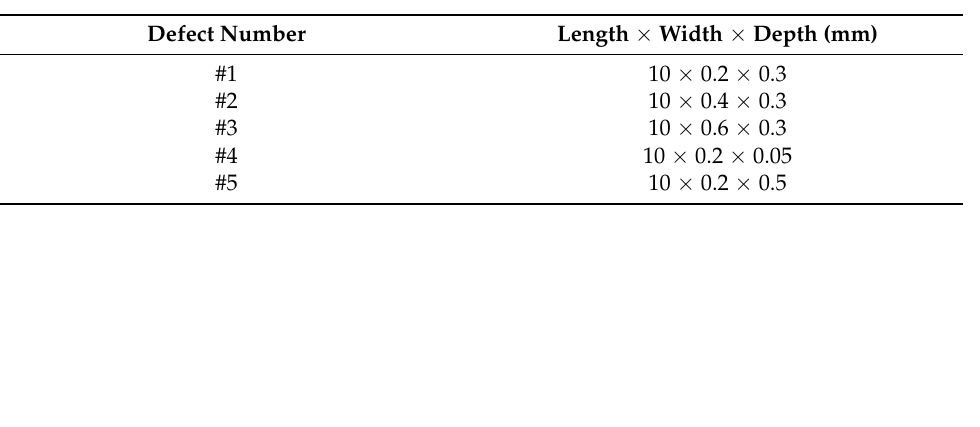
Table 1. Dimensions of the five types of artificial